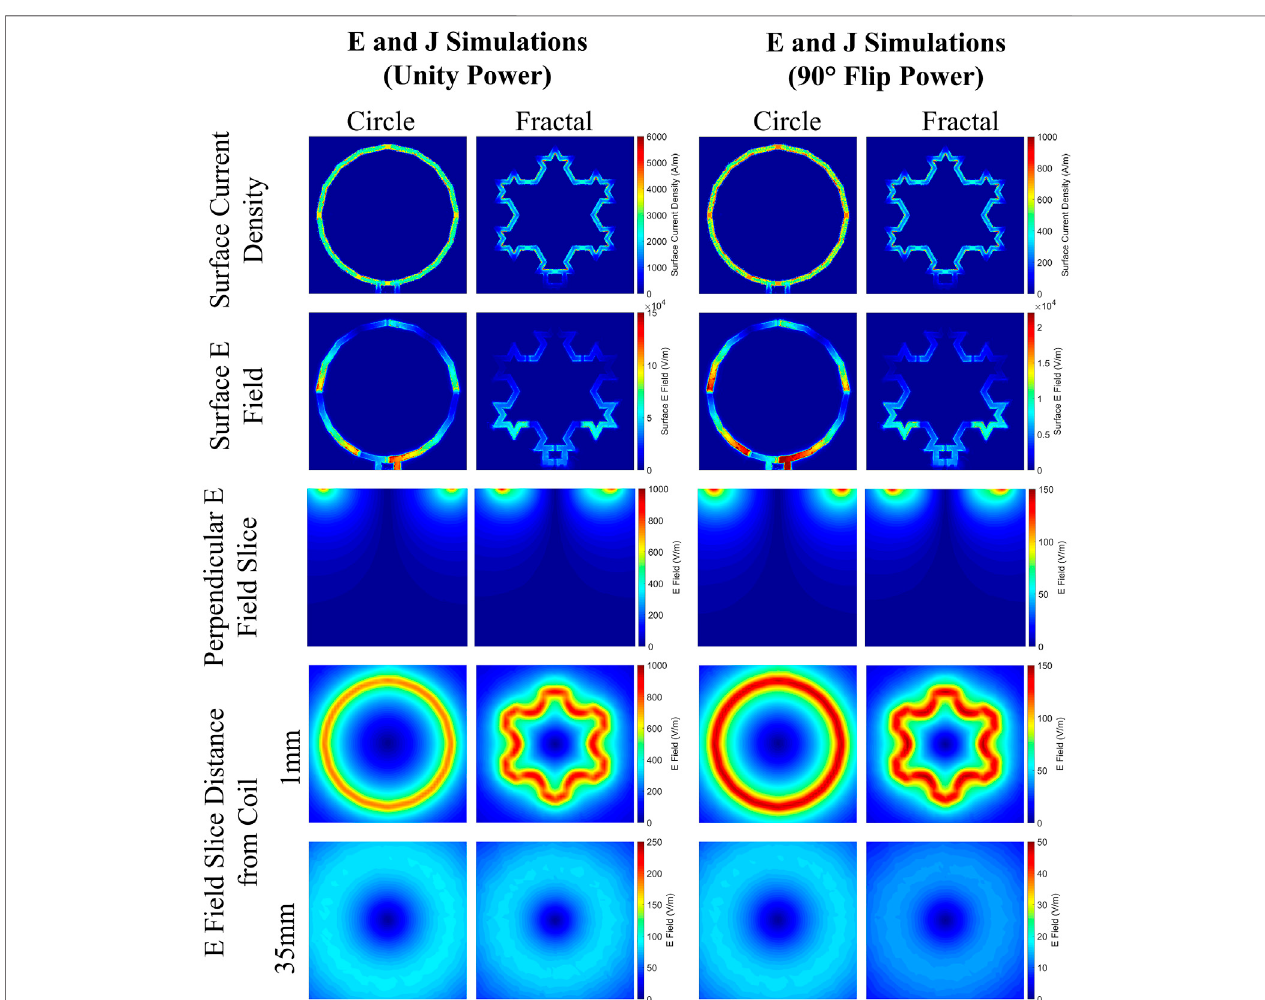
FIGURE 8 | The simulated surface current density, the surface electric fi eld, and the electric fi eld depositied in the phantom for both the circular and fractal coil.